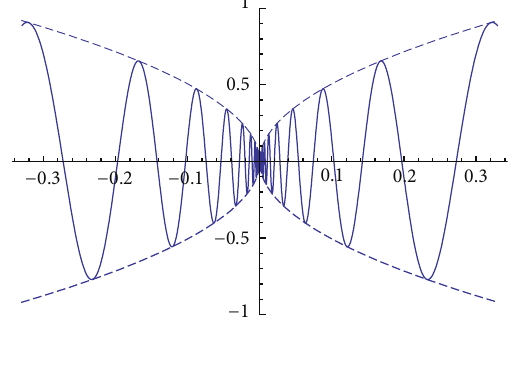
Figure 3: 𝑦 is two-sided oscillatory near 𝑥 = 0